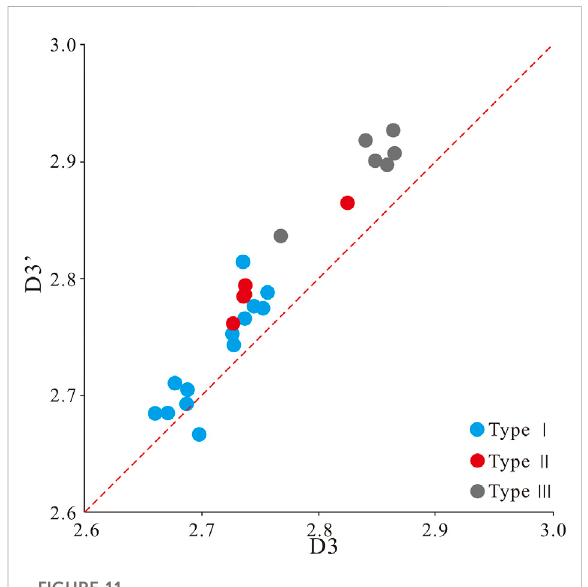
FIGURE 11 Fractal dimension of micro-minipores of Longtan shales.